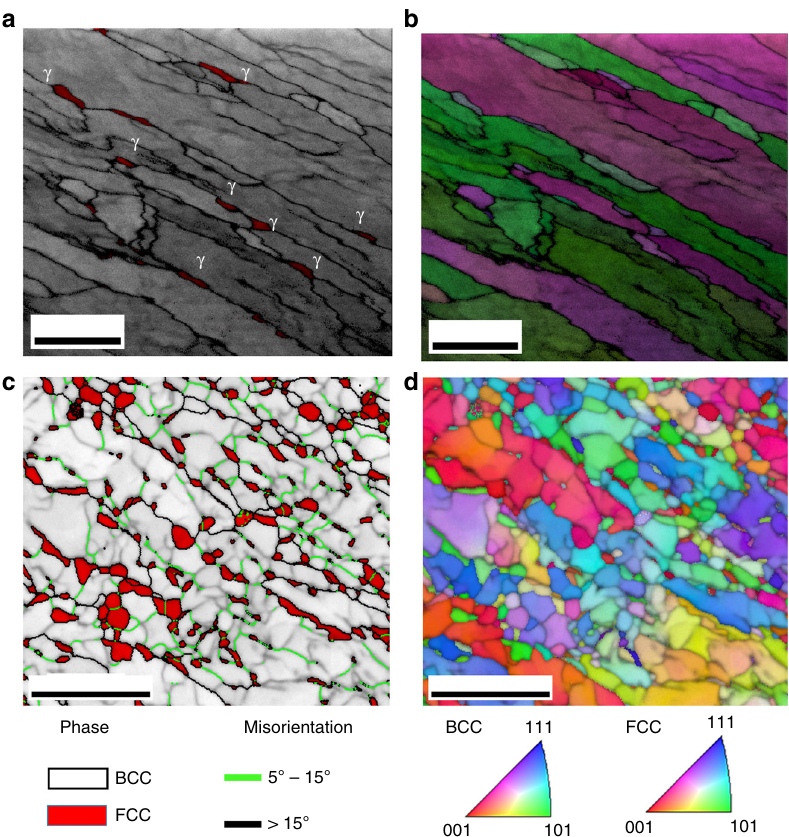
Fig. 6 Diffraction analysis of the alloy after 6 h and 2 months at 450 °C. a , b TKD analysis of the Fe-9 Mn alloy after 6 h at 450 °C. a Phase map plus image quality map in grayscale and b inverse pole fi gure of the normal direction of the same region shown in a . Scale bar, 500 nm. c , d EBSD analysis of the Fe-9 Mn alloy after 2 months at 450 °C. c Phase map plus an image quality map in grayscale and d inverse pole fi gure of the normal direction of the same region shown in c . Scale bar, 5 µ m. Austenite clearly nucleates in both high-angle and low-angle grain boundaries. γ represents the FCC-austenite